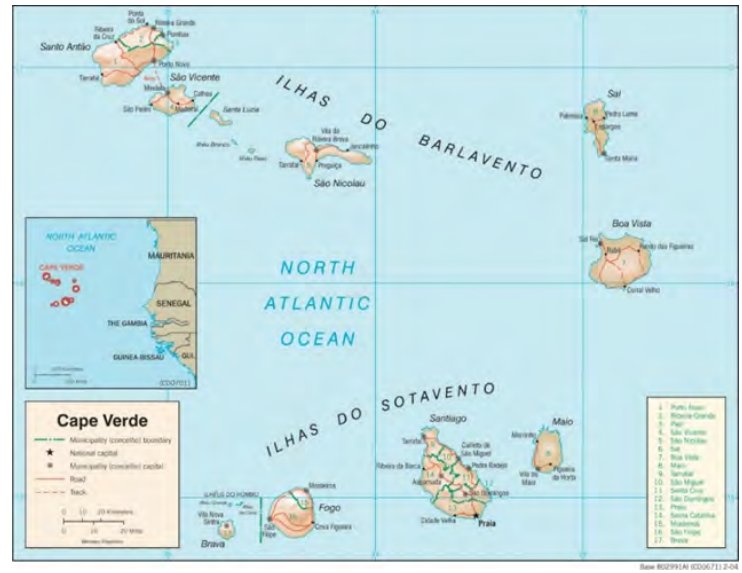
Figure 1. Cape Verde